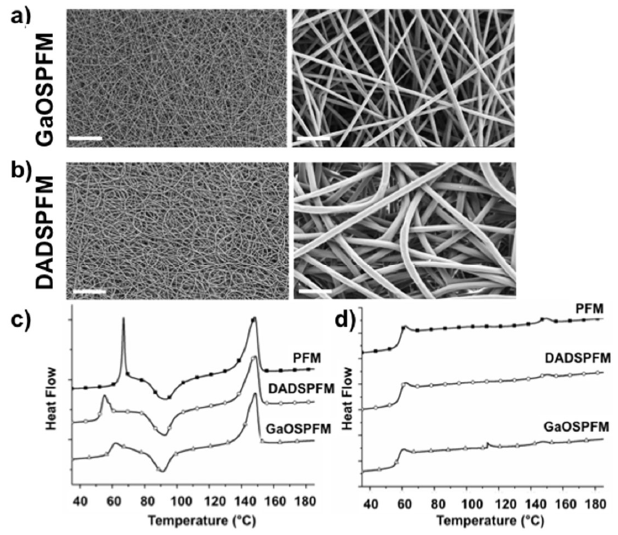
Figure 6. Microstructural and thermal characterization of functionalized PFM. SEM micrographs of ( a ) GaOSPFM and ( b ) DADSPFM (left: magnification 1k×, scale bar 50 μm, right: magnification 10k×, scale bar 5 μm); Differential scanning calorimetry (DSC) curves related to the first ( c ) and second ( d ) heating scans of PFM, DADSPFM and GaOSPFM.